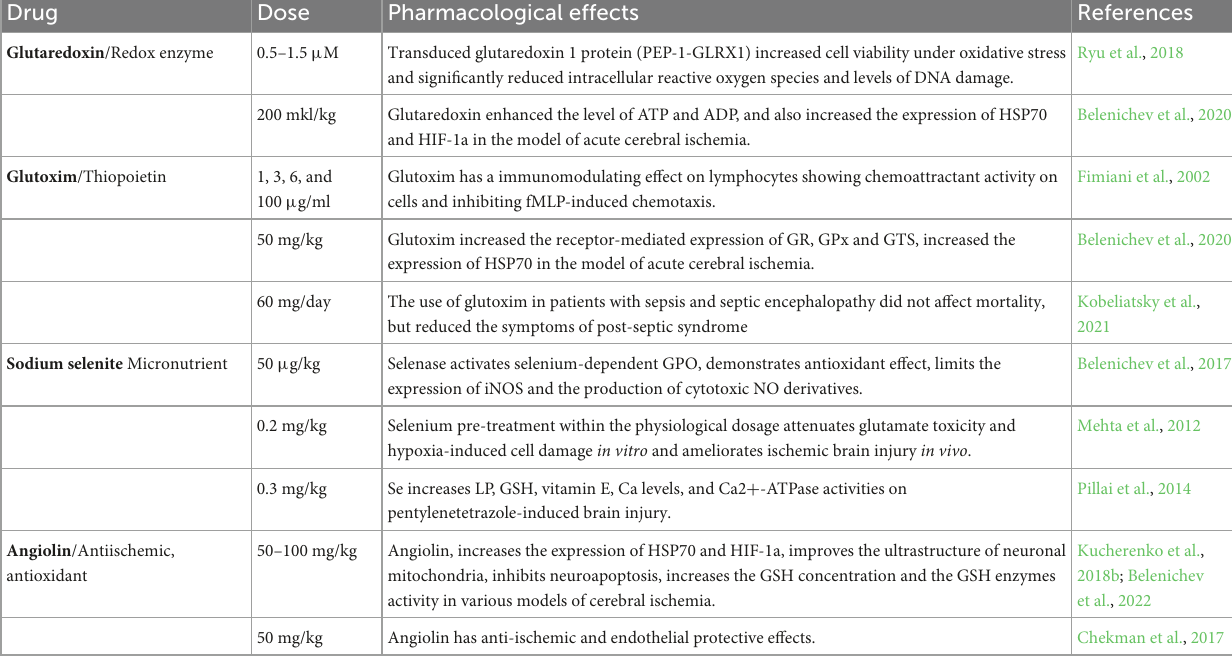
TABLE 2 Pharmacological characteristics of glutaredoxin, glutoxim, sodium selenite, and angiolin. Drug Dose